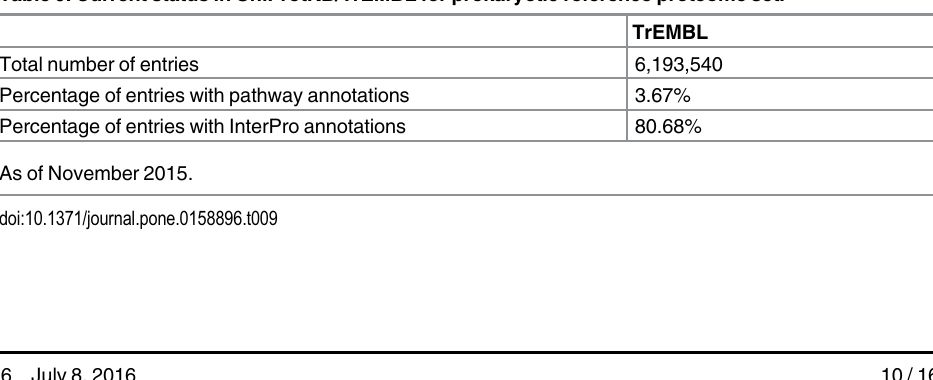
Table 9. Current status in UniProtKB/TrEMBL for prokaryotic reference proteome set.